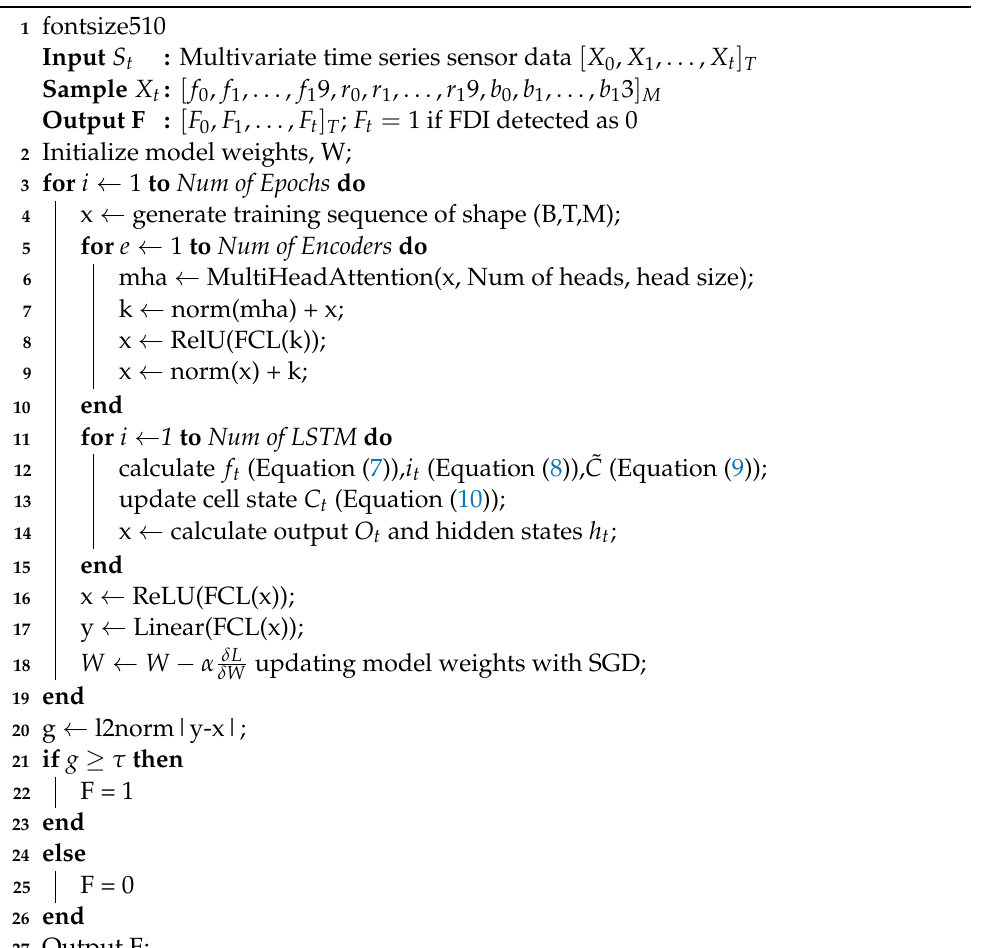
Algorithm 1: FDIA presence detection algorithm